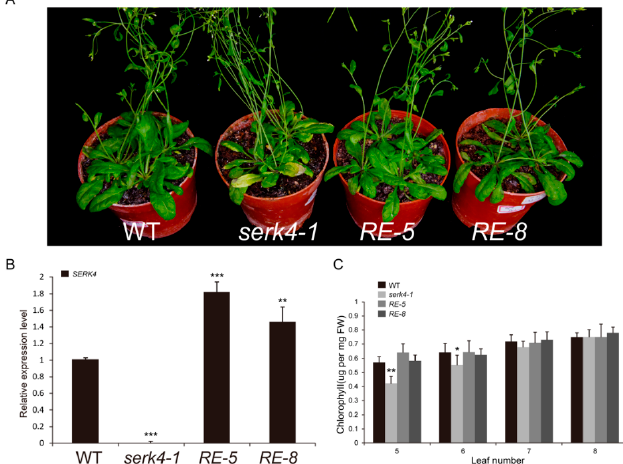
Figure 6. Complementation assay of the serk4-1 mutant with the SERK4 gene; ( A ) the leaf senescence phenotype of the five-week old wild-type, serk4-1 mutant and two rescue-line plants; ( B ) the expression level of the SERK4 gene in the wild type, serk4-1 mutant and two rescue lines, the ratios of SERK4 gene expression level were calculated relative to the wild type; ( C ) the chlorophyll contents of the wild type, serk4-1 mutant and two rescue lines. WT, wildtype; RE, rescue line. In B and C, the data are means ± SD of three biological repeats. * p <0.05, ** p <0.01, *** p <0.001 ( t -tests).